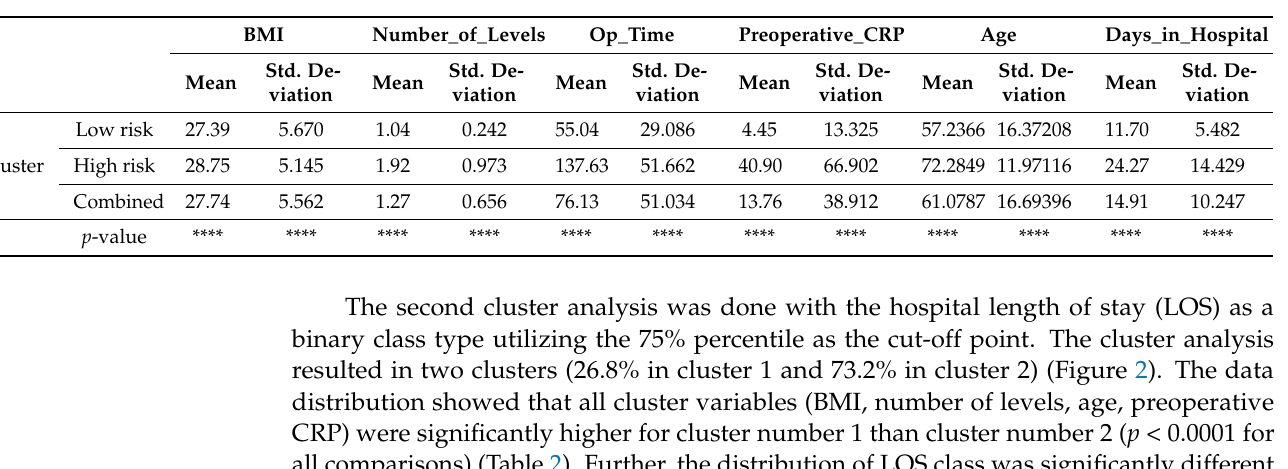
Table 1. Descriptive statistics and pairwise comparisons of the clusters were obtained through the K ‐ means cluster analysis, including the continuous scale feature hospital length of stay (LOS). **** p < 0.0001.